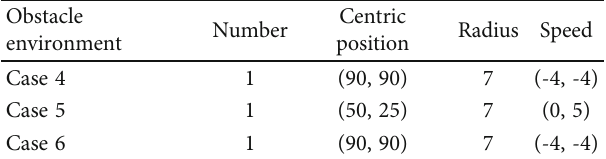
Table 2: Environmental settings of unknown dynamic